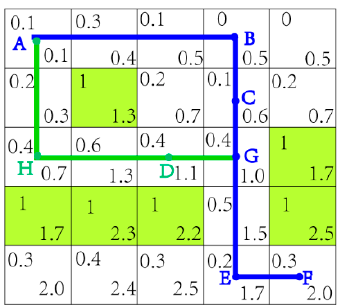
Figure 13. Path planning in the map with the dangerous potential field.